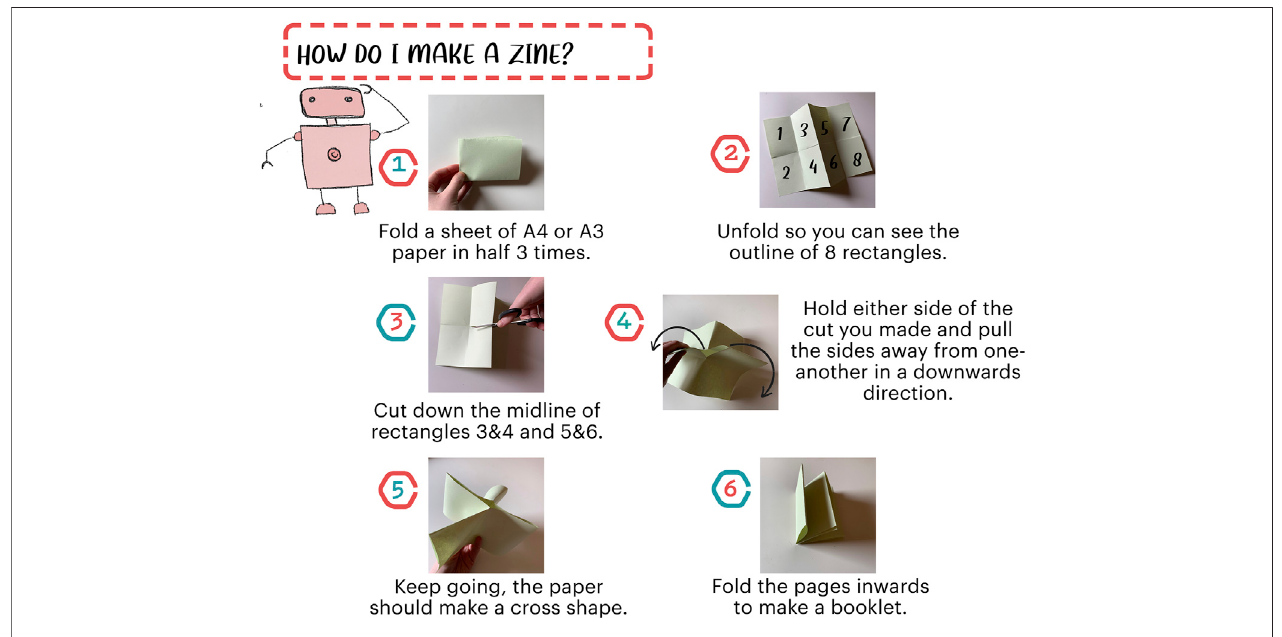
FIGURE 3 | Folding instructions for creating a